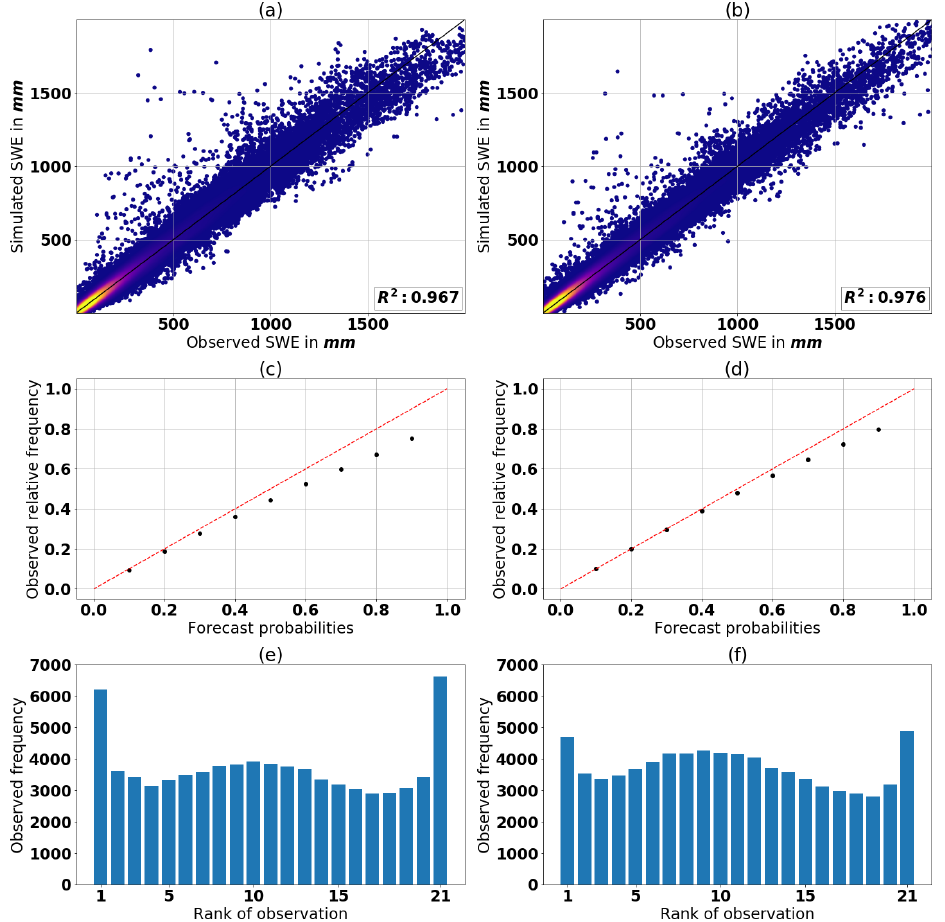
Figure 10. The scatter plot in panels (a) and (b) shows the median of the simulated ensemble against the observation for the single MLP ensemble (SMLP) and the multiple MLP ensembles (MMLP), respectively. Note that the axes are cut off at 2000mm. Zoomed out scatter plots are shown in Fig. 15. The reliability diagrams are presented in panel (c) for the SMLP and in panel (d) the MMLP. Further, the rank histograms are presented in panel (e) for the SMLP and in panel (f) the MMLP. All results shown are for the testing data